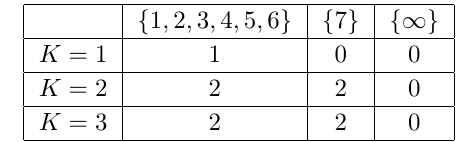
Table 3 . Number of Bethe roots for decomposed BAE with M = 6 . There are (cid:27) 0 (6) + 1 = 5 classes, which correspond to f 1 ; 5 g ; f 2 ; 4 g ; f 3 g ; f 6 g ; f1g . The numbers in brackets are the singular Bethe roots.